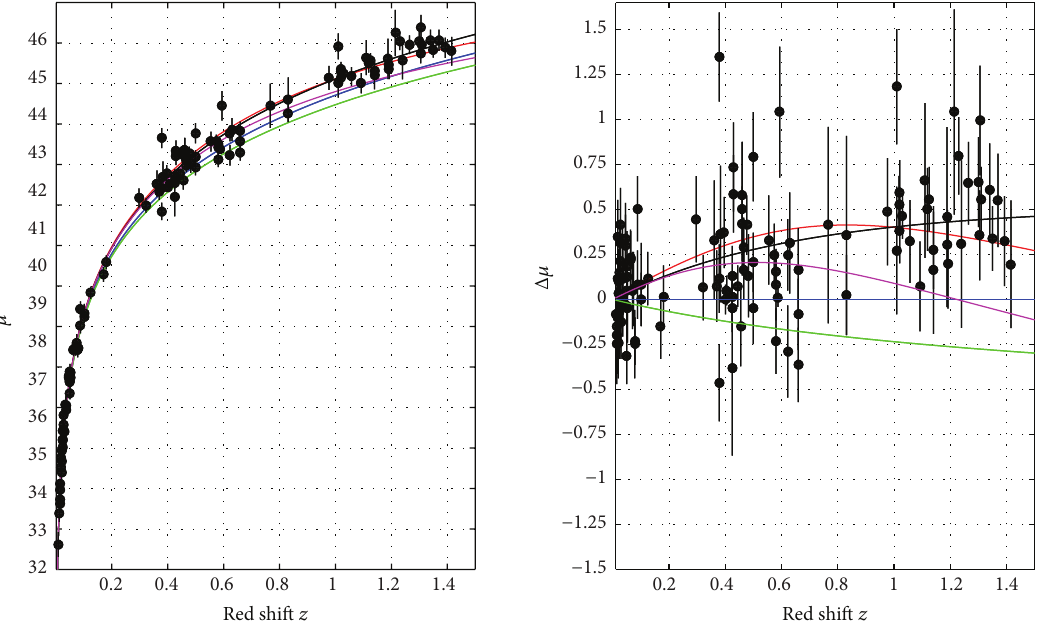
Figure 2: As in Figure 1 but on a linear